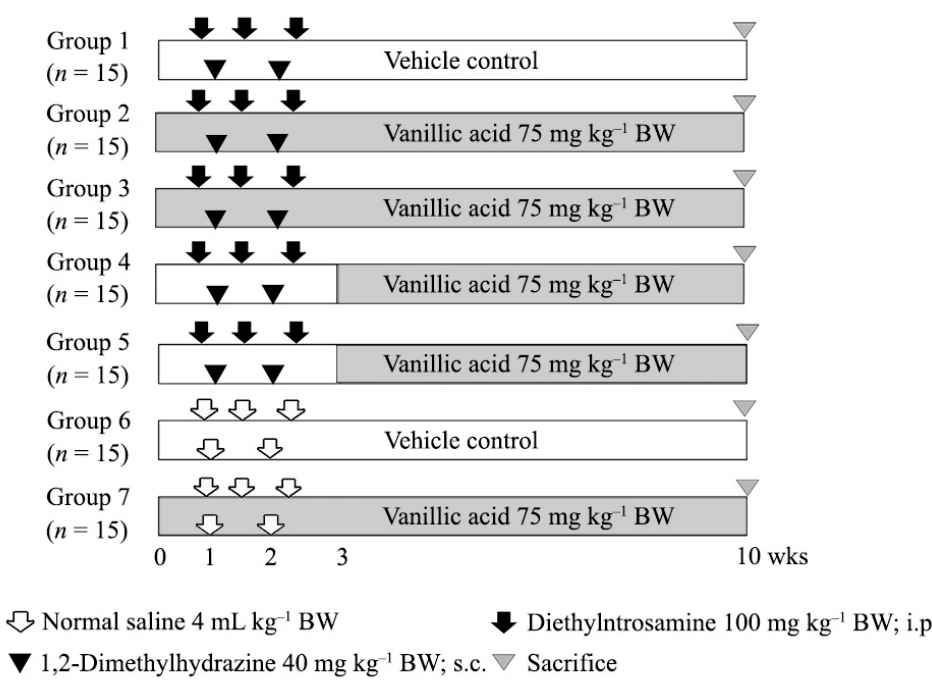
Figure 5. Experimental protocol.